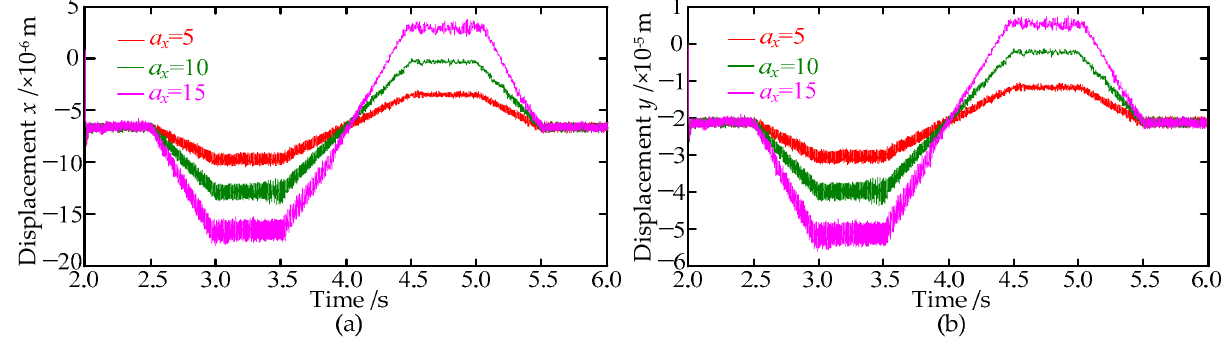
Figure 11. Displacement responses of node 14 under different non-inertial conditions: ( a ) x -direction; ( b ) y -direction.